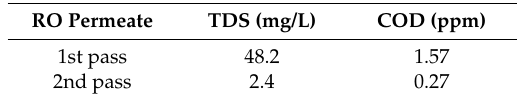
Table 3. Example of TDS and COD results of 1st and 2nd stage RO